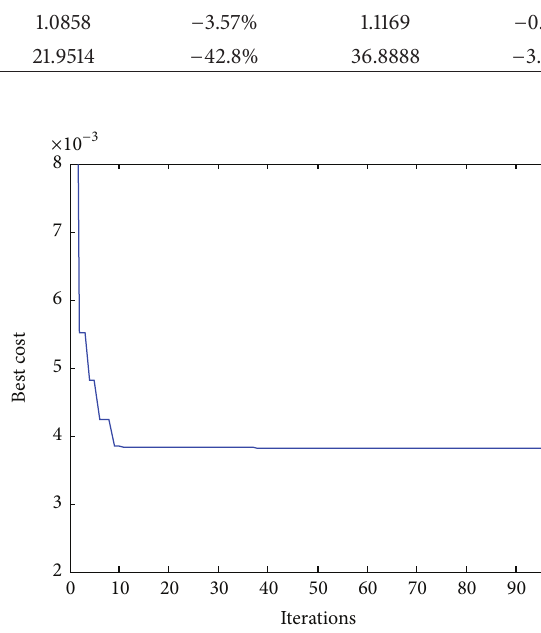
Figure 5: Convergence diagram of GA.